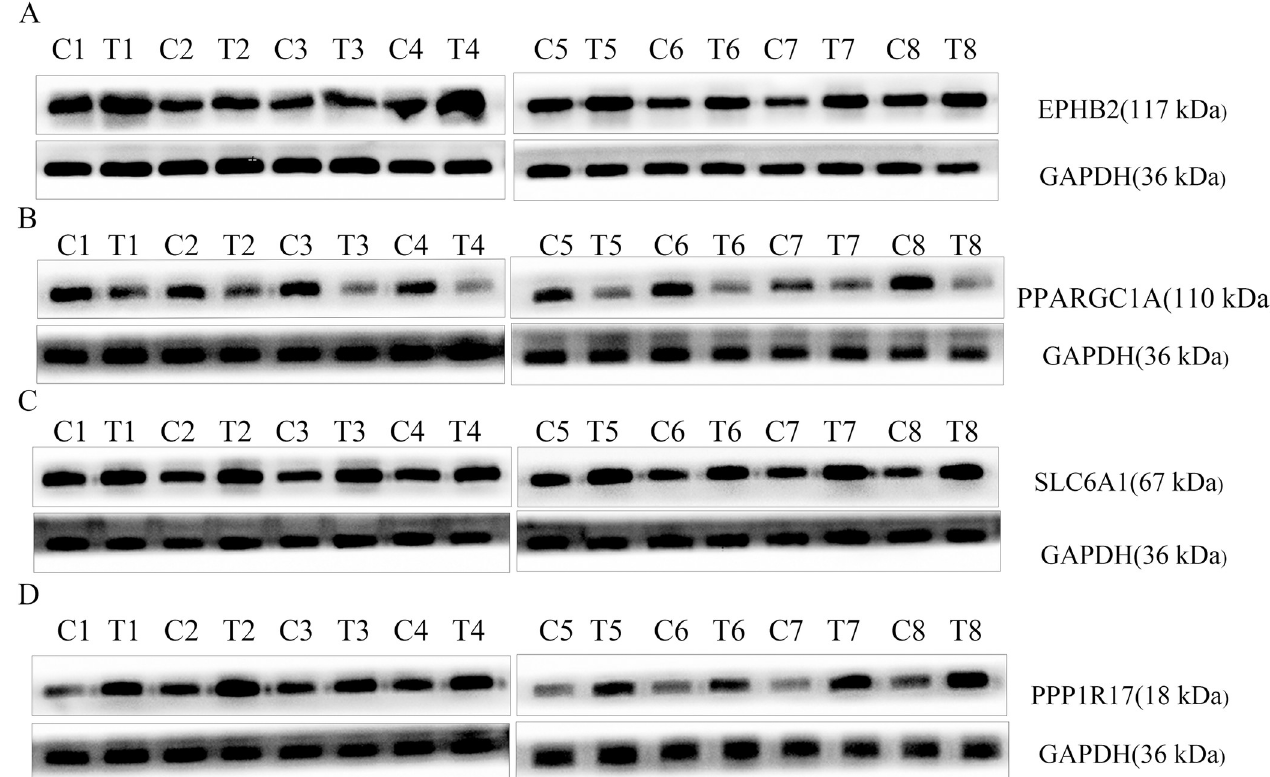
Fig 11. Expression of the four prognostic MRGs in eight pairs of tissues was detected by western blotting (T, COAD tissue;C, adjacent tissue). (A) EPHB2, (B) PPARGC1A, (C) SLC6A1, (D) PPP1R17.